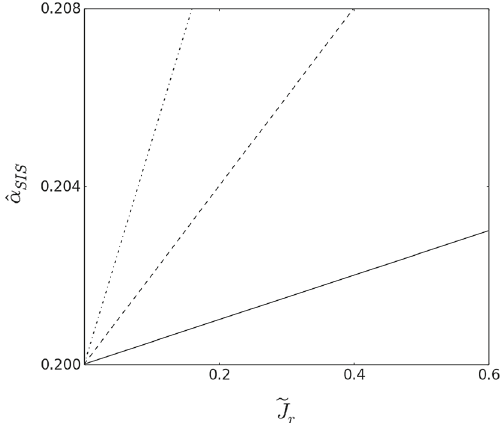
Fig. 7 Plot of ˆ α SIS vs. (cid:22) J r for Λ = 1 (continuous line), Λ = 0 . 25 (dashed line), and Λ = 0 . 1 (dot-dashed line). We used, b = 10, sin χ = 1, and ω 2 c /ω 2 = 0 .